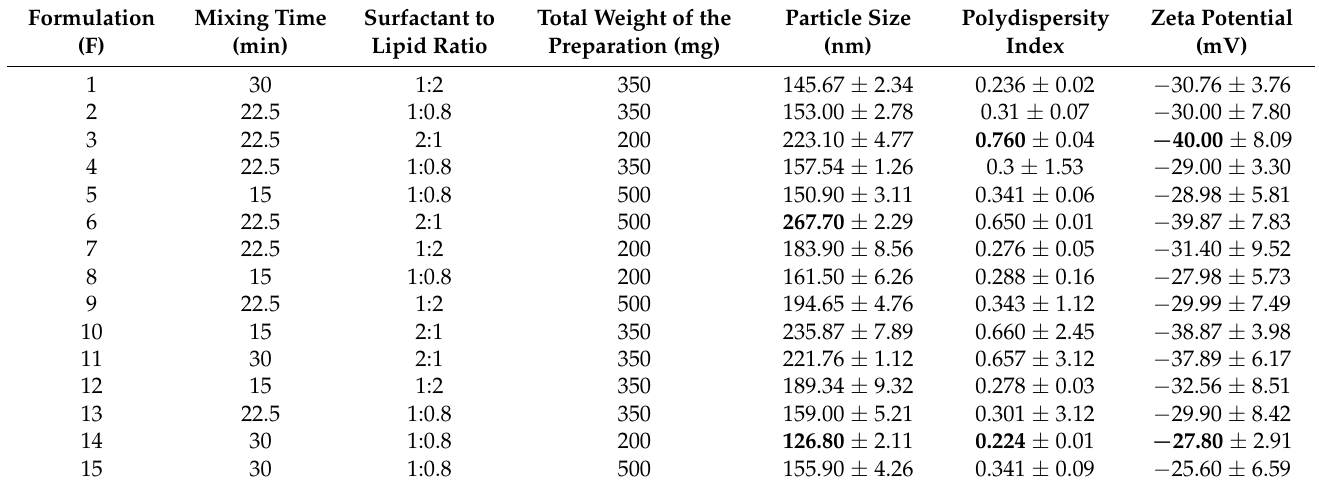
Table 4. Box-Behnken design with actual values of the variables